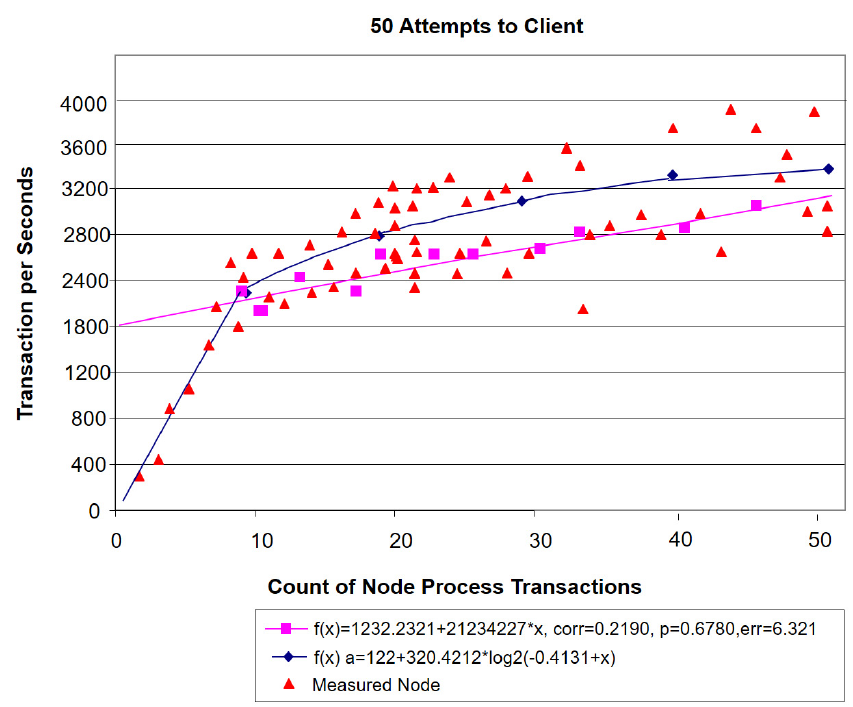
Figure 13. Existing security system application model (one round).